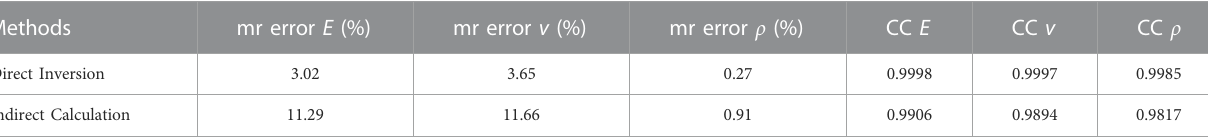
TABLE 3 The mr error and CC between the true models andthe estimation results of E, v, and ρ , respectively, for different methods ina multilayer geologic model.